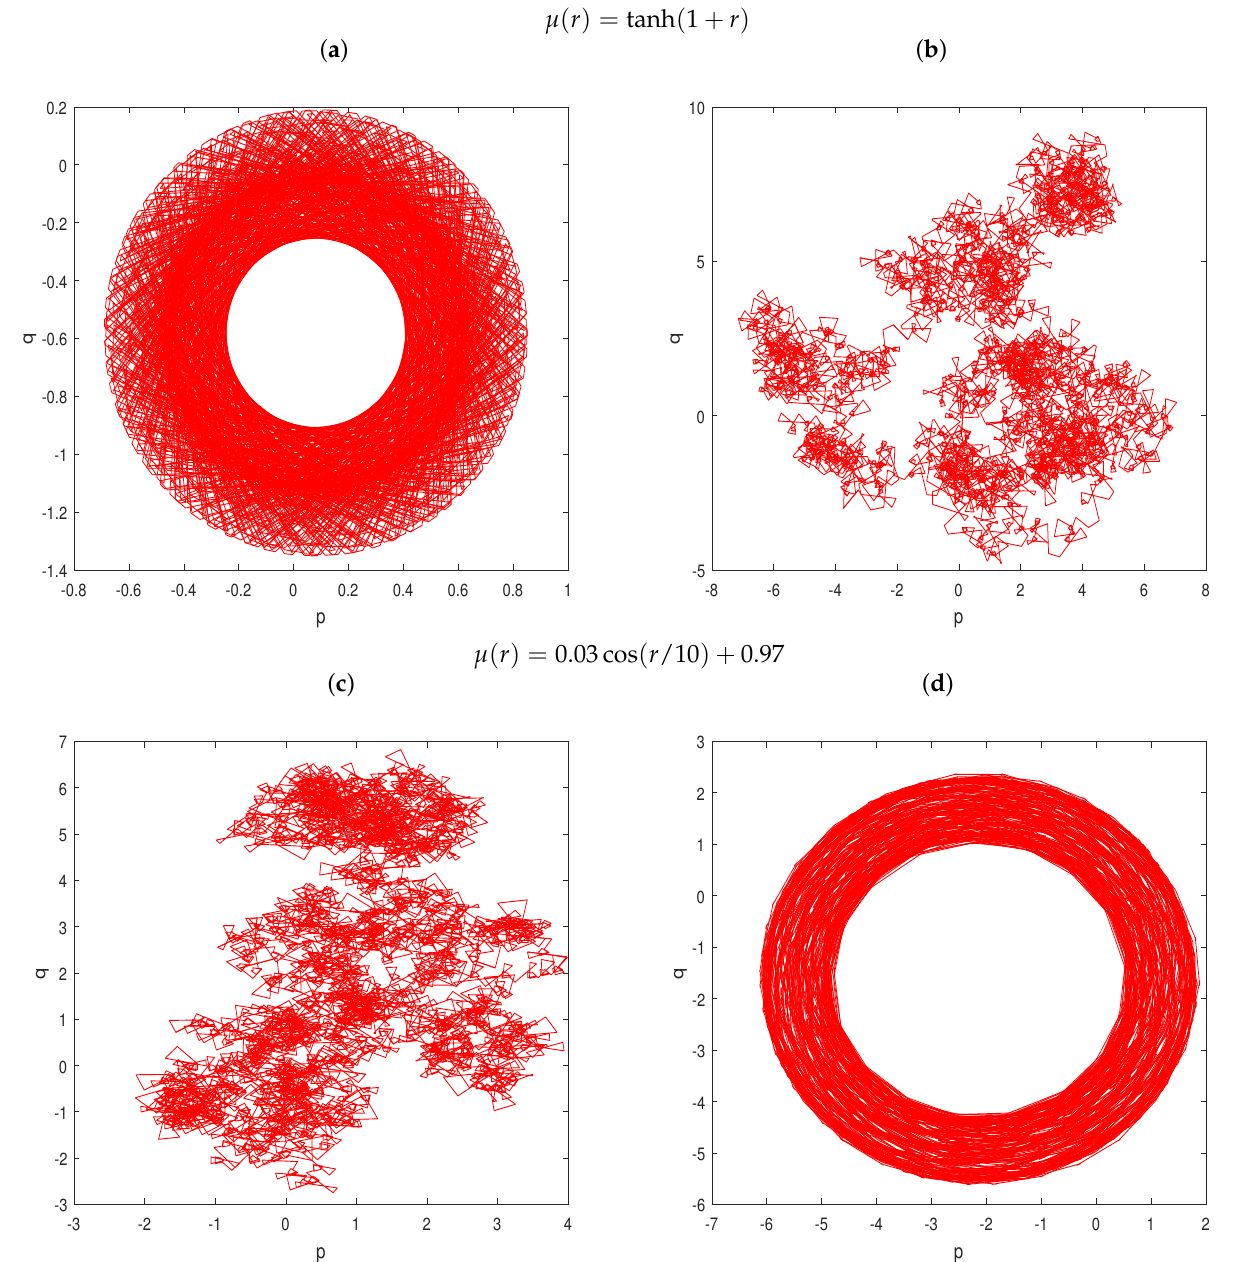
Figure 6. The p-q plots of the 0–1 test of the system (8) with different fractional variable-orders and values of β : ( a ) β = − 0.6013, ( b ) β = − 0.30, ( c ) β = − 0.58, ( d ) β = −